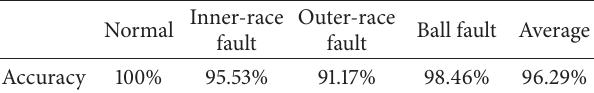
Table 9: Fault identification results using